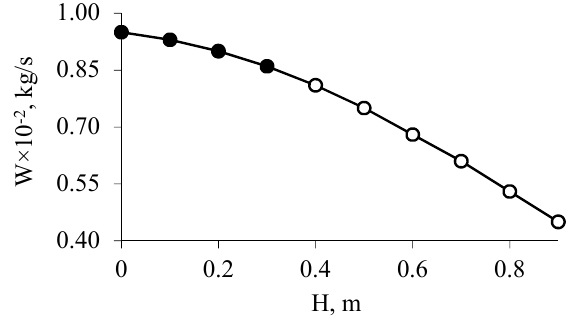
Fig. 3. Change in efficiency for the secondary steam depending on the liquid level of the rotary-film evaporator (